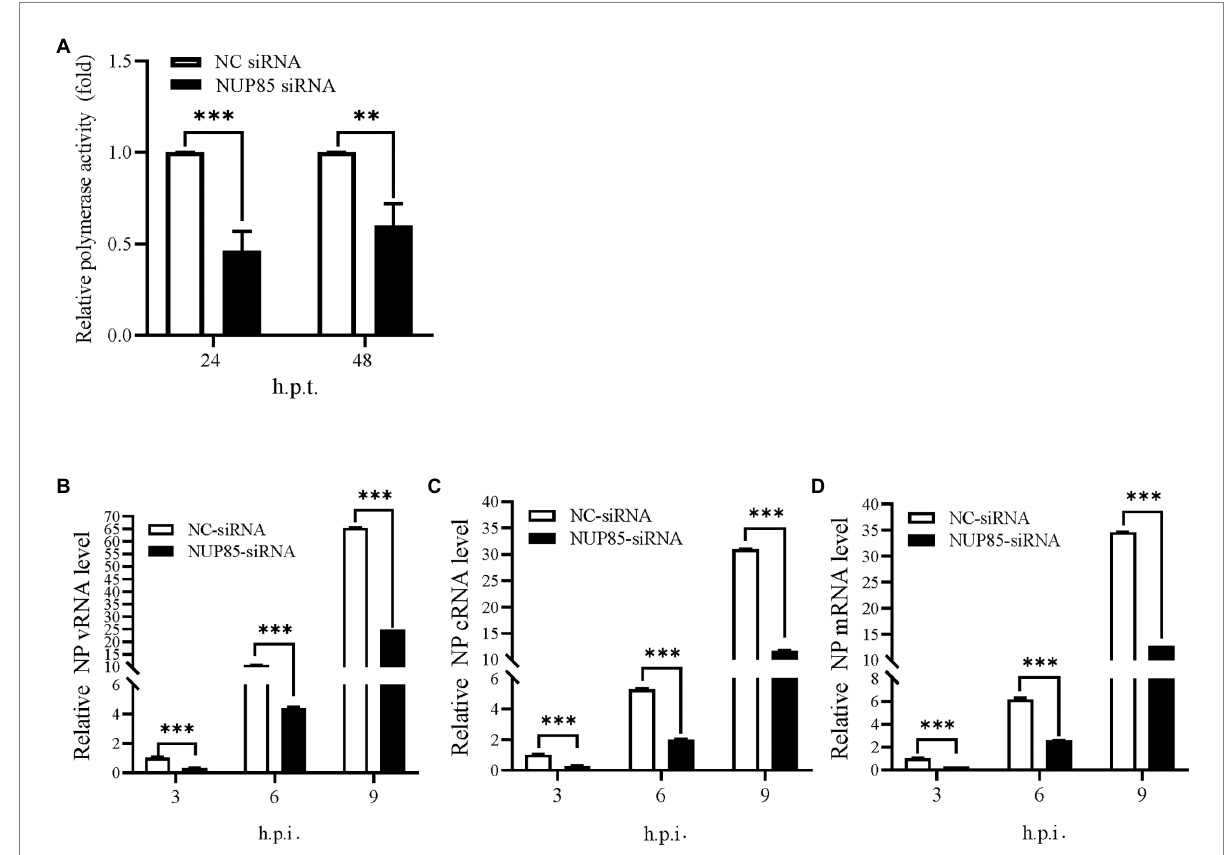
FIGURE 2 Knockdown of NUP85 inhibits polymerase activity and suppresses RNA synthesis during IAV infection. (A) HEK293T cells treated with NUP85 siRNA or NC siRNA were transfected with vRNP reconstitution plasmids together with Renilla plasmids. Luciferase activities were measured at 24 and 48 h.p.t., and Renilla luciferase was used as an internal control. (B–D) A549 cells were transfected with NUP85 siRNA and NC siRNA for 24 h and then infected with influenza A virus JSC1 (MOI = 2). Cells were harvested for RNA isolation at 3, 6, and 9 h.p.t., followed by qRT-PCR to detect vRNA, cRNA and mRNA relative expression level of NP. The viral RNA levels were normalized to the 18S rRNA level. Data are mean ± SD of three independent experiments. Significance is measured by unpaired T -test; ** indicates p < 0.01. *** indicates p <